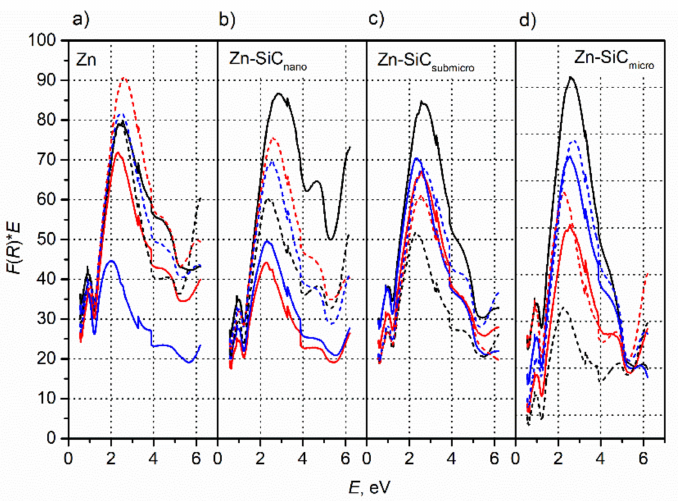
Figure 3. [ F ( R )* E ] vs. E dependences based on DRS spectra recorded for various coatings deposited under different conditions: ( a ) Zn, ( b ) Zn-SiC nano , ( c ) Zn-SiC submicro , and ( d ) Zn-SiC micro (black—